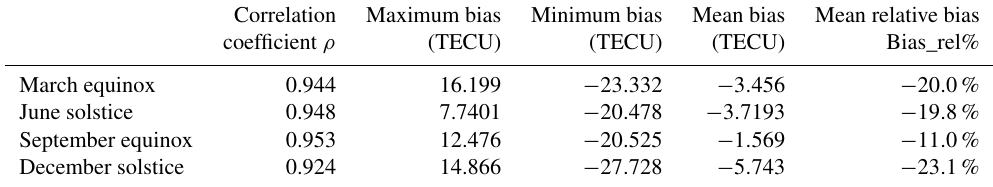
Figure 3. Daily (a) RMS of the differences between global IRI-TEC and GIM-TEC, (b) solar F10.7 index, and daily (c) average geomagnetic AE index in 2013. Table 1. Correlation coefficient and bias statistics among the season averages of global IRI-TEC and GIM-TEC at 12:00UT in 2013.